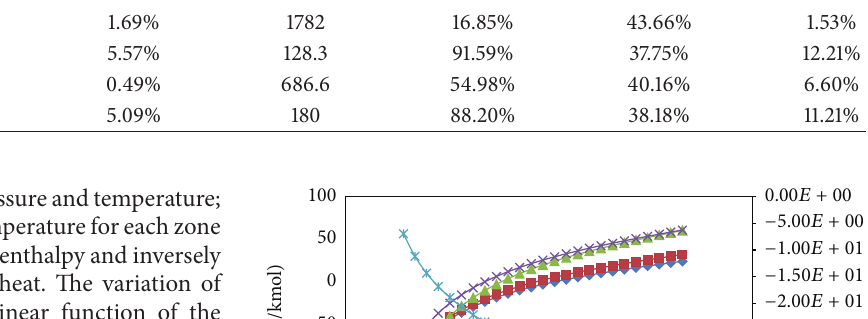
Table 6: Comparative experimental and simulated results for methyl ester biodiesel and each surrogate at 1700 rpm. RPM MEB 1700 Experimental